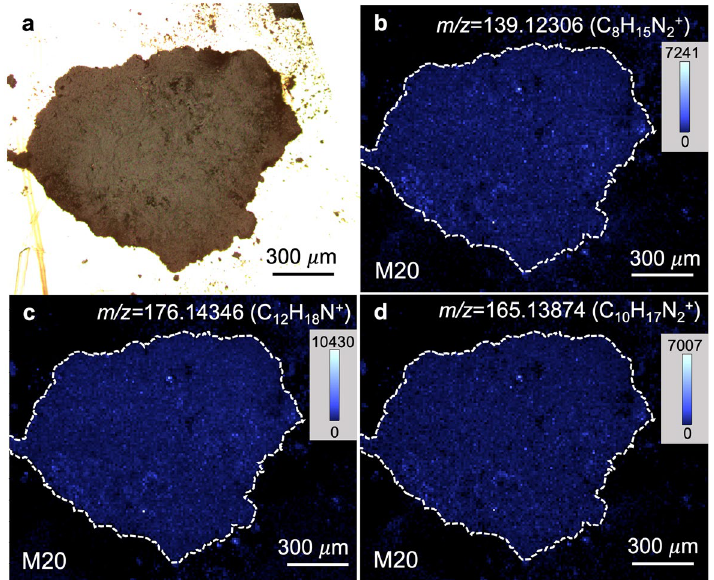
Figure 3. Similarity in the spatial distributions of CHN compounds in the Murchison meteorite. ( a ) Optical reflection image. ( b ) Mass imaging of m/z = 139.12306 in cluster M20 corresponds to C 8 H 15 N 2 + . ( c ) Mass imaging of m/z = 176.14346 in cluster M20 corresponds to C 12 H 18 N + . ( d ) Mass imaging of m/z = 165.13874 in cluster M20 corresponds to C